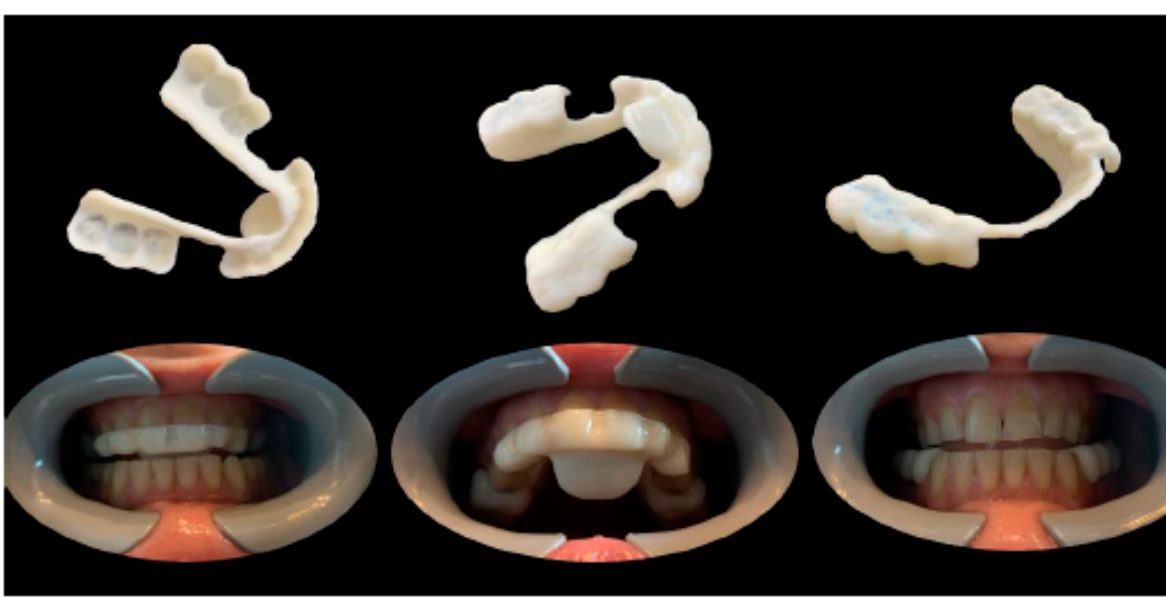
Figure 12. White or transparent material.